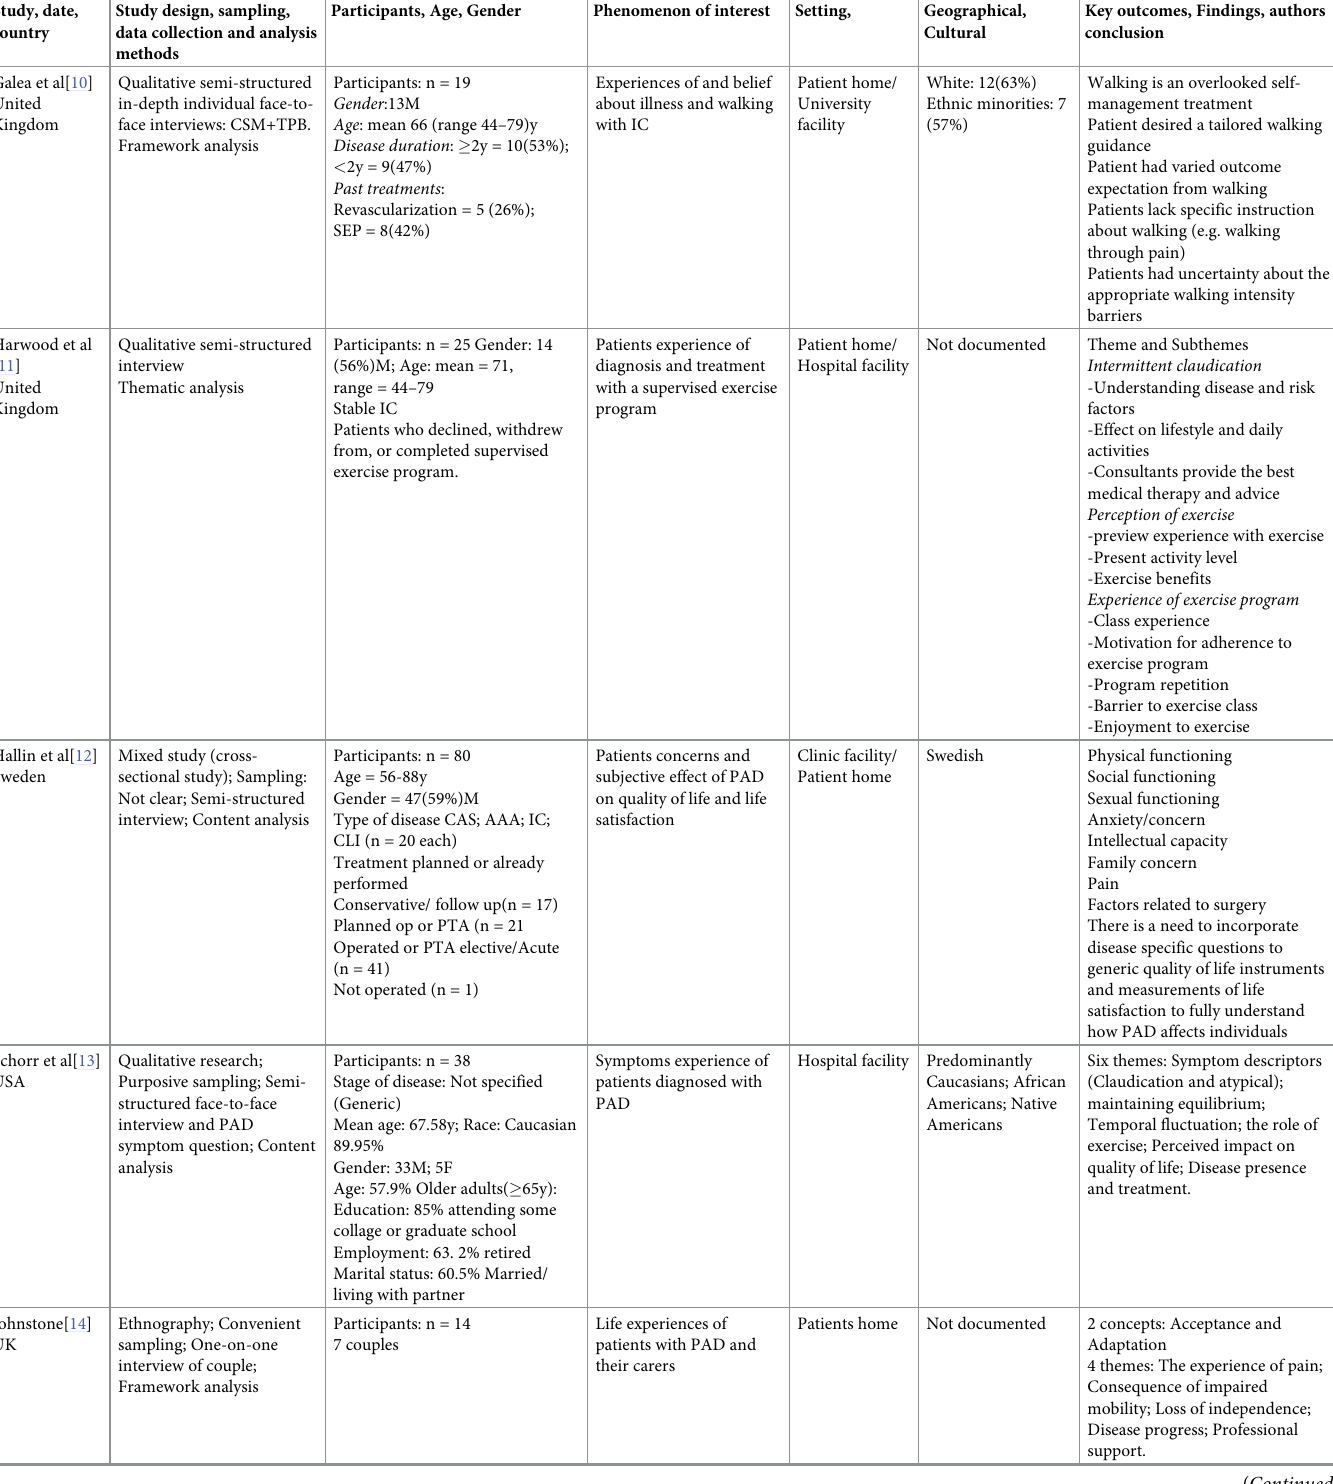
Table 1. Table of data extraction and characteristics of included